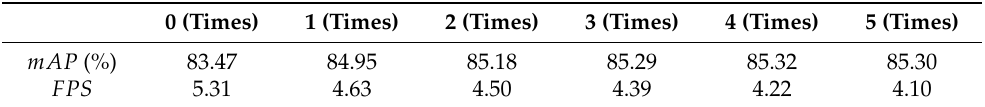
Table 2. Test on different numbers of